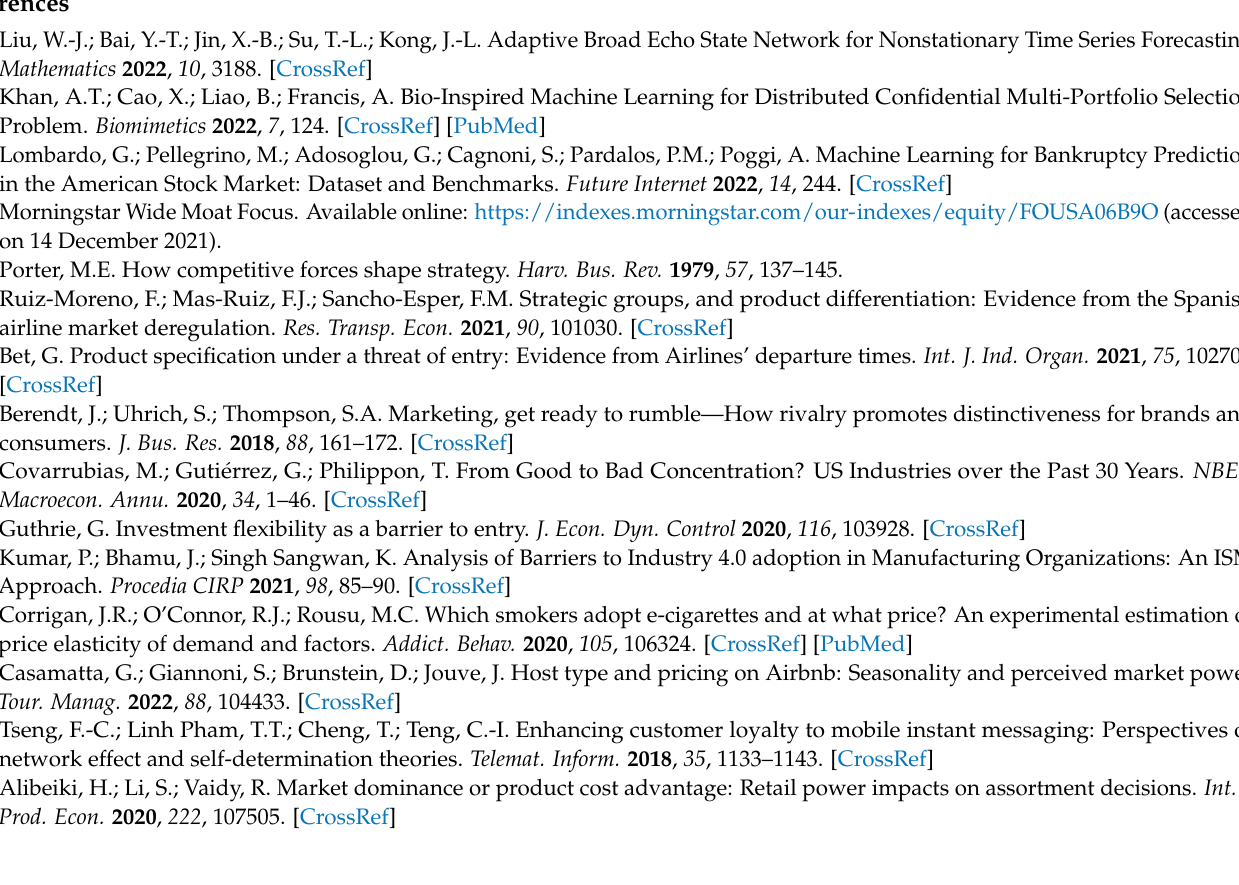
Figure A3. Dependence plot of companies with no moat.